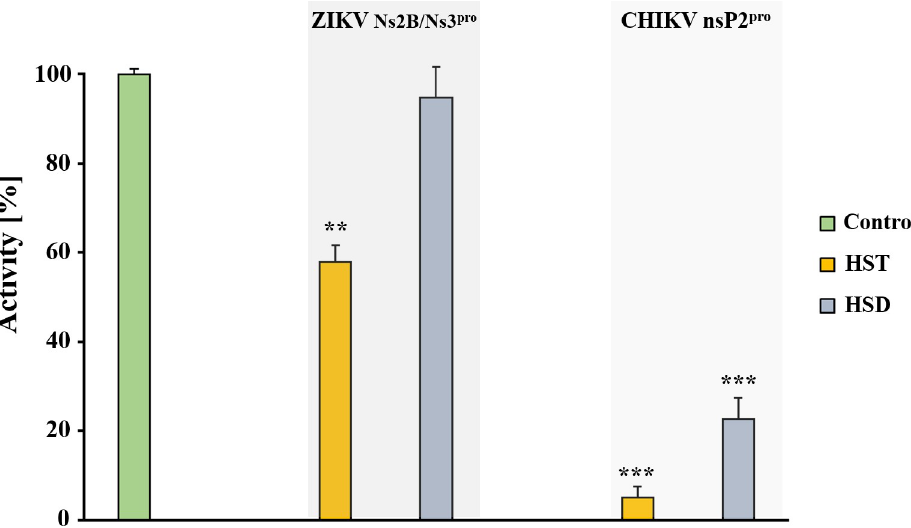
Fig 2. Preliminary inhibition test of HST and HSD against ZIKV NS2BNS3 pro and CHIKV nsP2 pro . The tested compound concentration was 20 µ M. HST inhibit ZIKV NS2B/NS3 pro activity about 40% and CHIKV nsP2 pro about 90%. The inhibition of CHIKV protease activity by HSD was higher than 60%. Contrary, HSD shows not relevant inhibition against ZIKV NS2B/NS3 pro . Data shown are the means ± SD from three independent measurements (n = 3). Asterisks mean that the data differs from the control (0 µ M inhibitor) significantly at p < 0.01 ( �� ) and p < 0.001 ( ��� ), level according to ANOVA and Tukey’s test.